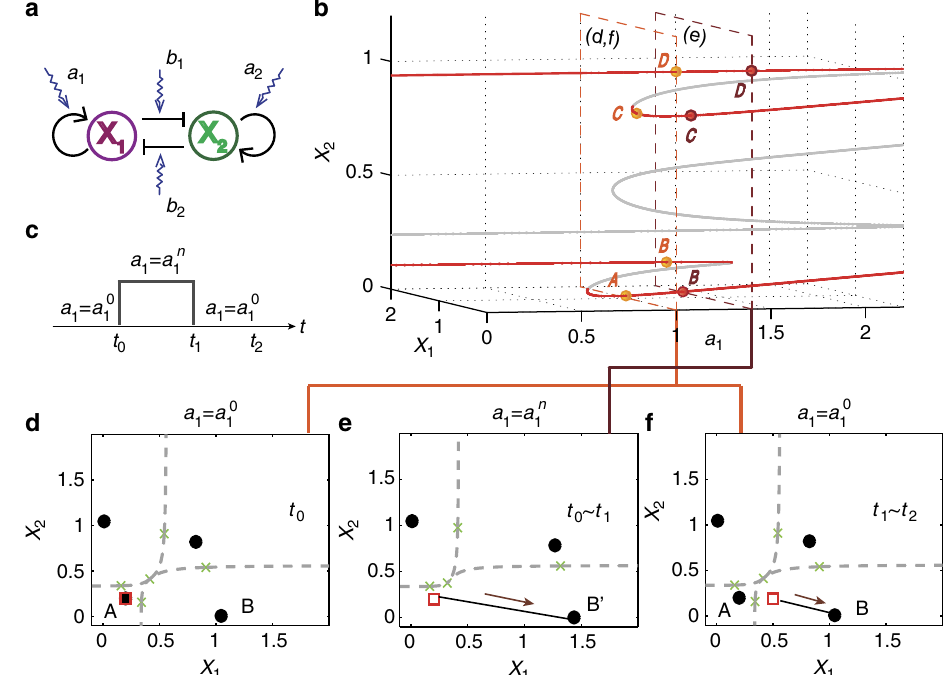
Figure 4 | Control of a GRN of two nodes. ( a ) Simplified model of the two-node GRN, where the arrowhead and bar-head edges represent activation and inhibition regulations, respectively, and the sawtooth lines denote the strength of the tunable edge. ( b ) Bifurcation diagram with respect to the control parameter a 1 , where the red and grey solid lines denote the stable and unstable steady states, respectively. In the two parallel cross-sections (with dashed and a 1 ¼ a n , the yellow and brown dots represent the corresponding stable attractors, respectively. ( c ) Control signals required to line boundaries) for a 1 ¼ a 0 1 1 drive the system from attractor A to attractor B . In d – f , grey dashed lines represent the basin boundaries; black solid circles and green crosses denote , the system is at a low concentration state A , and the target attractors and unstable steady states, respectively. ( d ) For the initial parameter setting, a 1 ¼ a 0 1 state is B . ( e ) By changing a 1 from a 0 to a n , attractor A is destabilized and its original basin is absorbed into that of the intermediate attractor B 0 , so the 1 1 system approaches B 0 . ( f ) When control perturbation upon a 1 is released, the landscape recovers to that in d . Once the system has entered the basin of the 1 : 0, a n 1 : 4, t 0 ¼ 0, t 1 ¼ 23 and t 2 ¼ target state B during the process in e it will evolve spontaneously towards B . Parameters in simulation are a 0 1 ¼ 1 ¼